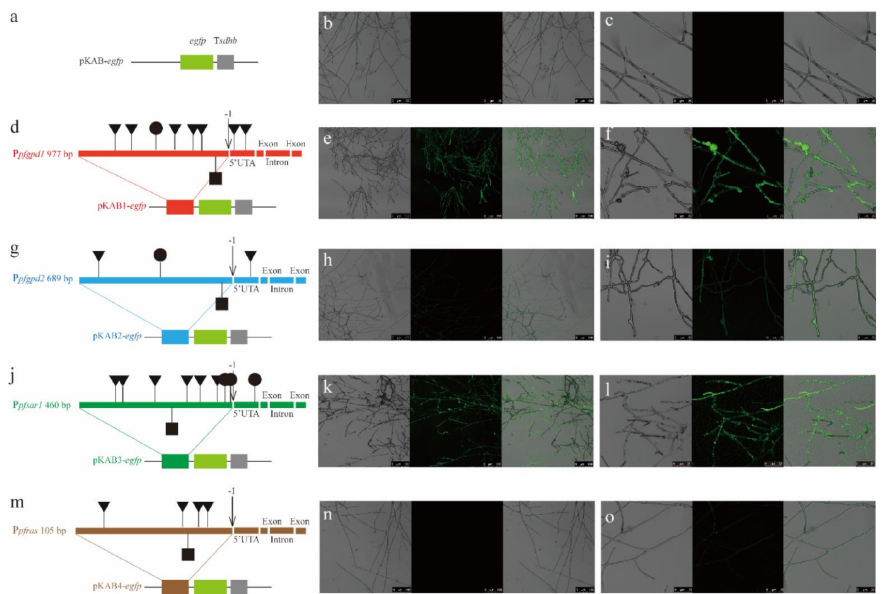
Figure 5. Transcription initiation efficiency of four endogenous promoters in P. eryngii var. ferulae . ( a ) pKAB- egfp , which does not contain any promoter, was used as the negative control; ( d , g , j , m ) P pfgpd1 , P pfgpd2 , P pfsar1 , and P pfras were analyzed for core cis-responsive elements and in- serted into the pKAB-overexpression plasmid to express the egfp gene. In the diagrams, filled squares indicate TATA boxes, filled inverted triangles indicate CAAT boxes, and filled circles indicate GC boxes; ( b , c ), ( e , f ), ( h , i ), ( k , l ). ( n , o ) Phase-contrast, fluorescence, and merged images of transformant mycelium, including P. eryngii var. ferulae :: pfgpd1 - egfp , P. eryngii var. ferulae :: pfgpd2 - egfp , P. eryngii var. ferulae :: pfsar1 - egfp , and P. eryngii var. ferulae :: pfras - egfp . The scale bars in ( b , e , h , k , n ) are 25 µ m and the scale bars in ( e , f , i , l , o ) are 100 µ m.